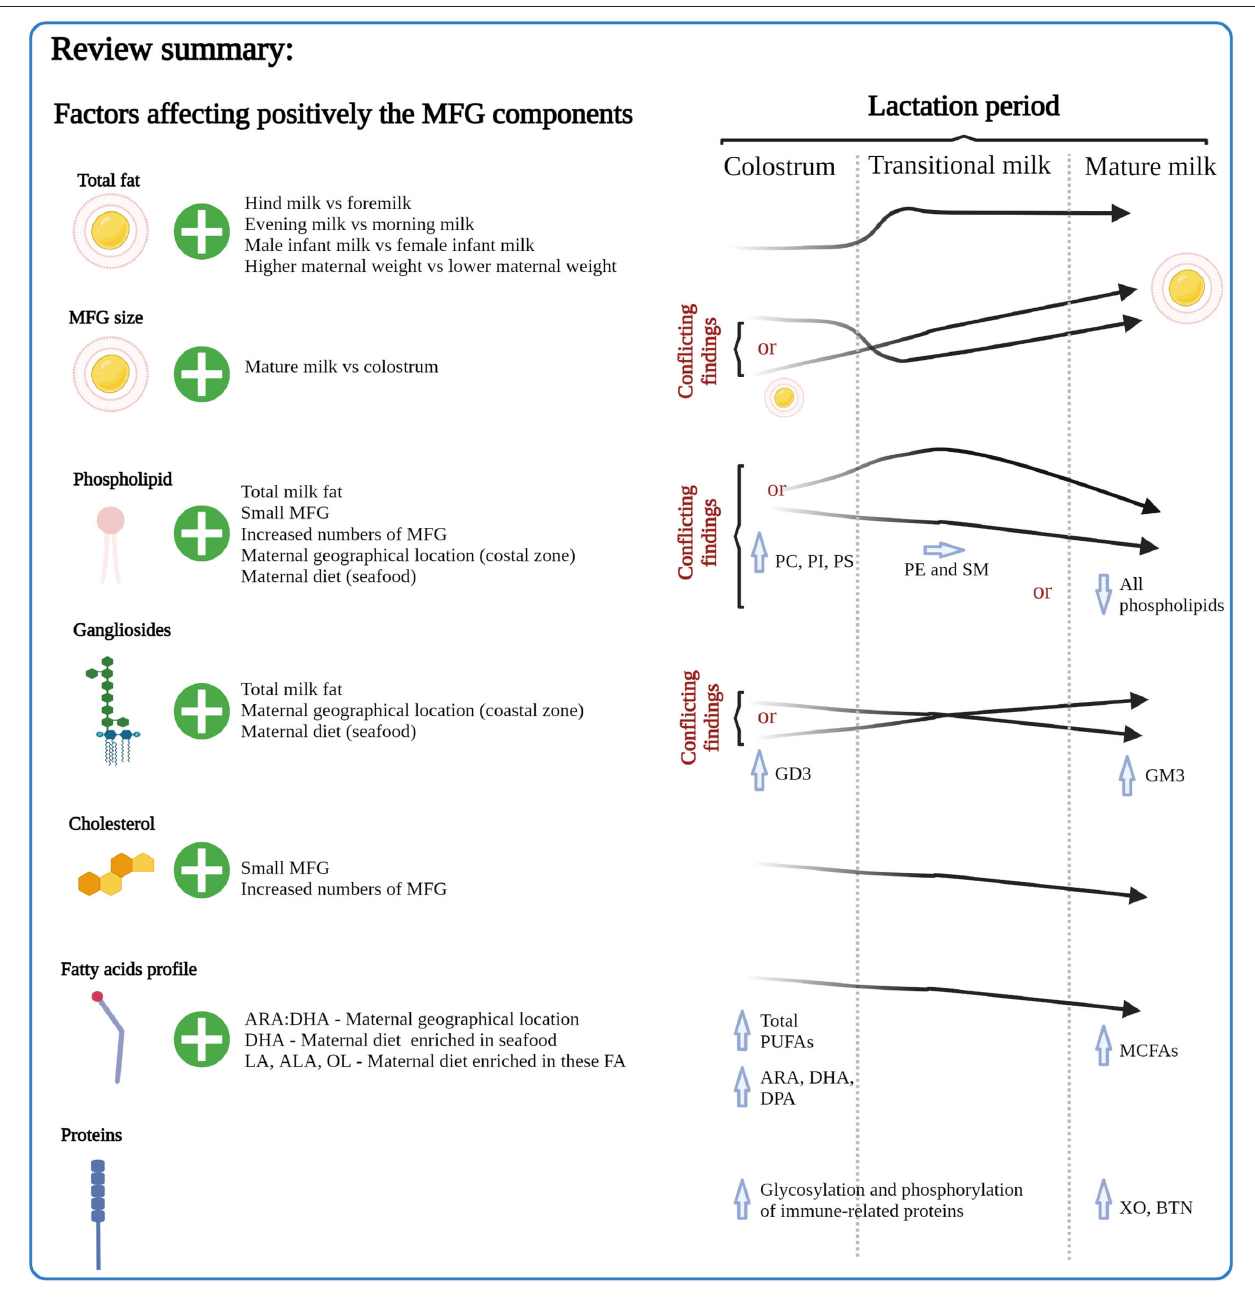
FIGURE 7 | Summary of the factors affecting MFG composition emphasizing the effects of lactation period. MFG, milk fat globule; ARA, arachidonic acid; DHA, docosahexaenoic acid; DPA, docosapentaenoic acid; ALA, α -linolenic acid; LA, linoleic acid; OL, oleic acid; XO, xanthine oxidase; BTN,